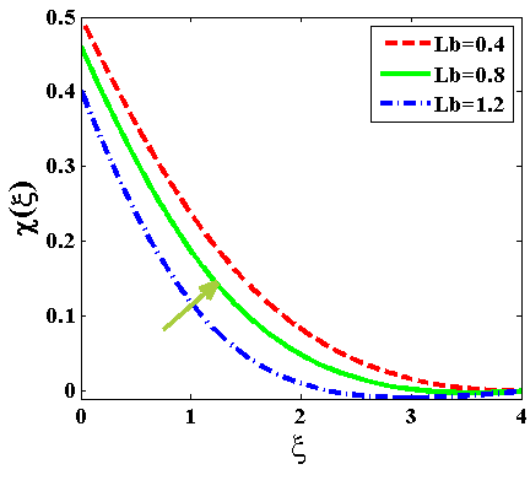
Figure 25. Outlines of 𝜒 at diverse quantities of 𝐿𝑏 .